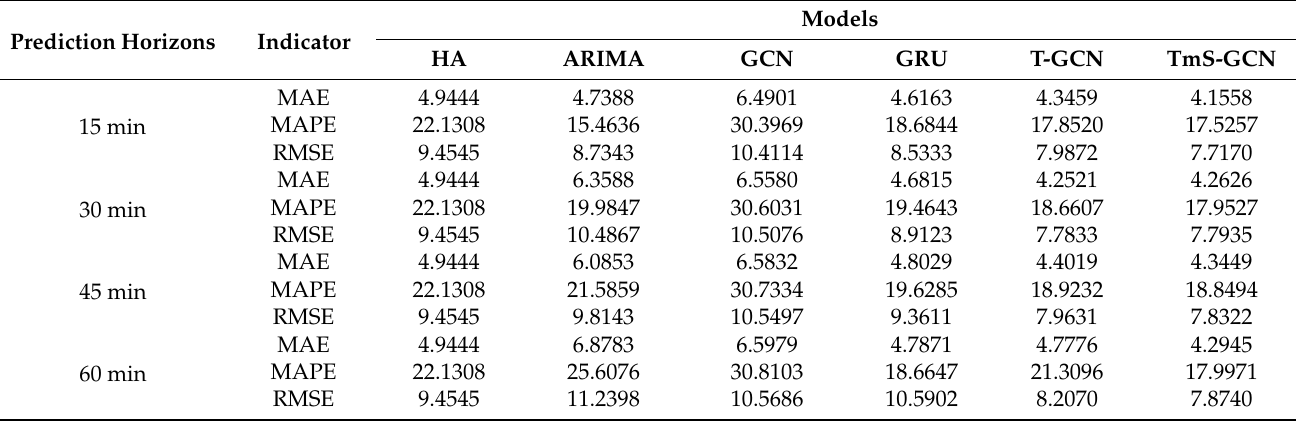
Table 2. Comparison of prediction